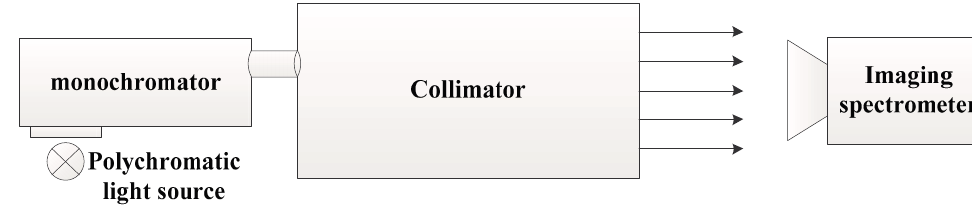
Figure 9. The sketch of the monochromator method for the spectral